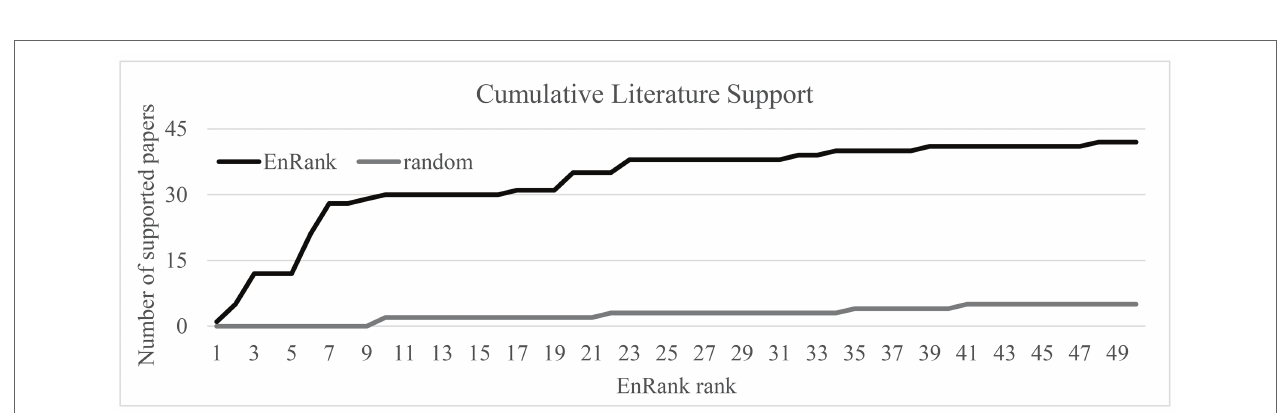
FIGURE 5 | The EnRank metrics of the 269 features in the union of the four lists of top-100 ranked features. The horizontal axis gave the feature ranks ordered by the EnRank metric, and the vertical axis gave the EnRank metrics of the top-ranked 269 features. These features were among the union of the top-100 ranked features recommended by the four algorithms, Ttest, Chi2, Ridge, and